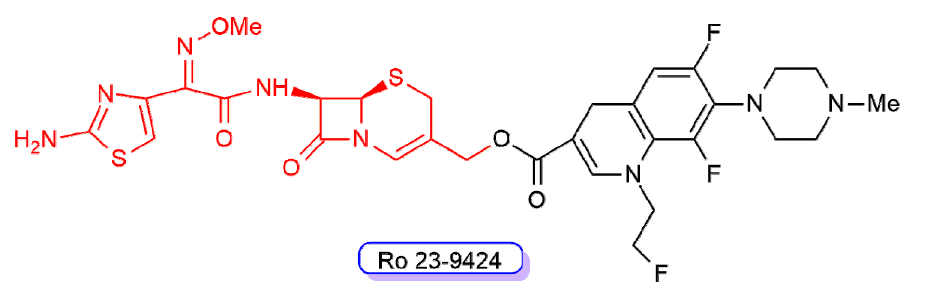
Figure 10. Chemical structure of compound RO-239429. The third-generation cephalosporin scaffold is highlighted in red, whereas the fluoroquinolone scaffold is shown in black.